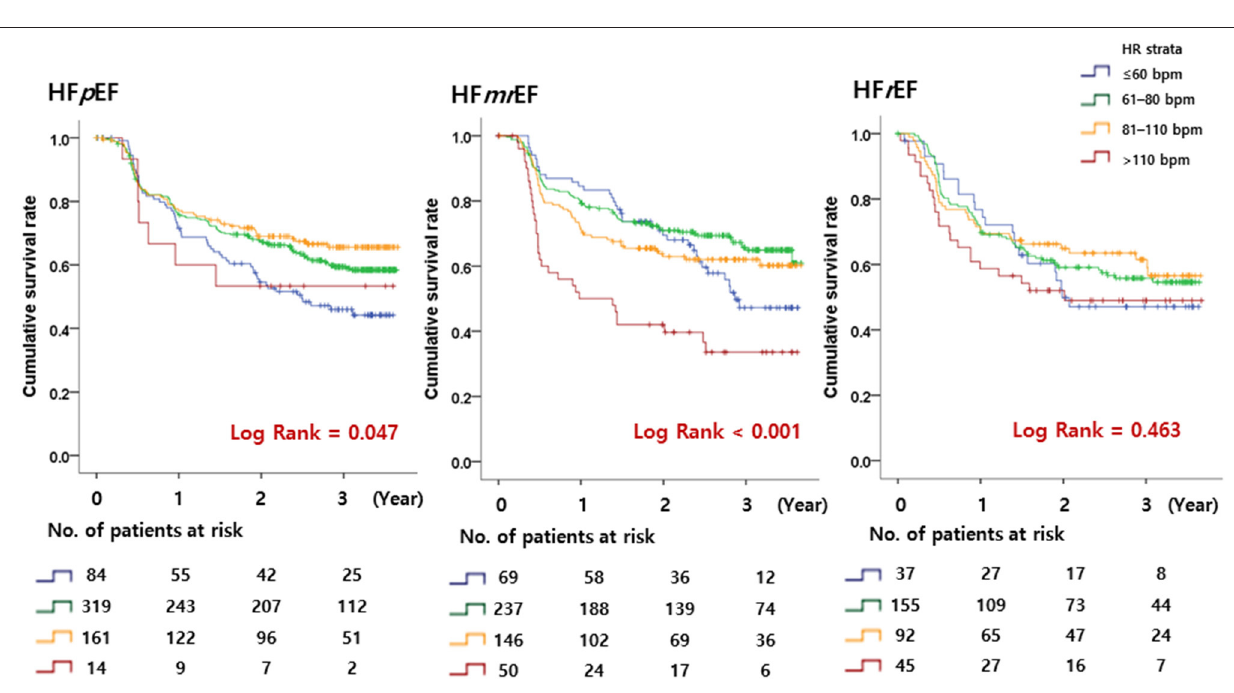
FIGURE 3 | Kaplan–Meier curves. The primary endpoint according to the heart rate in patients with HFpEF, HFmrEF, and HFrEF is shown. HFpEF, heart failure with preserved ejection fraction; HFmrEF, heart failure with mid-range ejection fraction; HFrEF, heart failure with reduced ejection